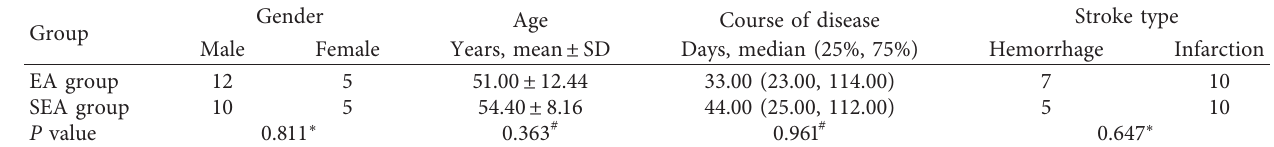
Table 1: Participants’ demographic